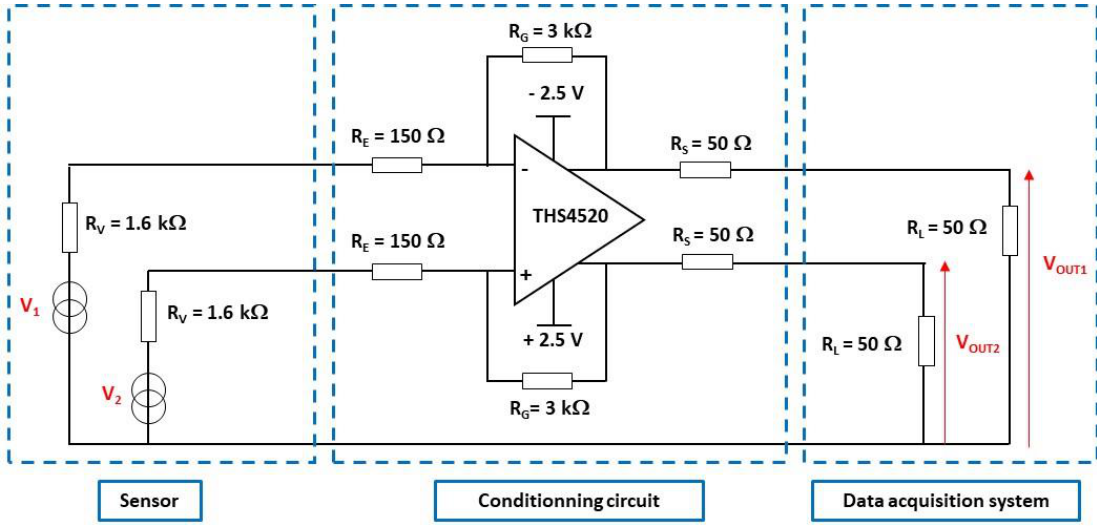
Figure 20. Architecture of the conditioning circuit embedded inside the measurement setup.